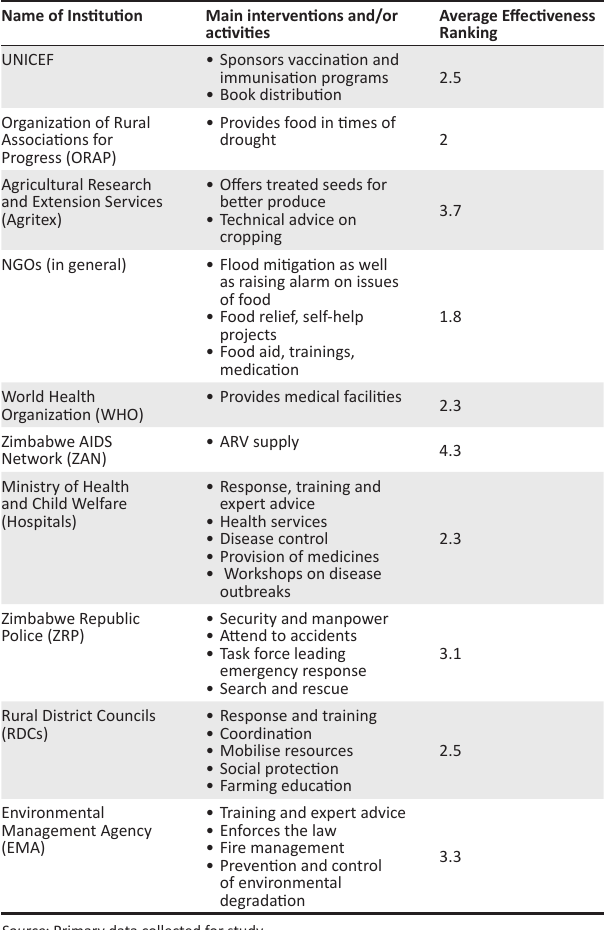
TABLE 4: Institutions and their involvement in disaster risk reduction. Name of Institution Main interventions and/or